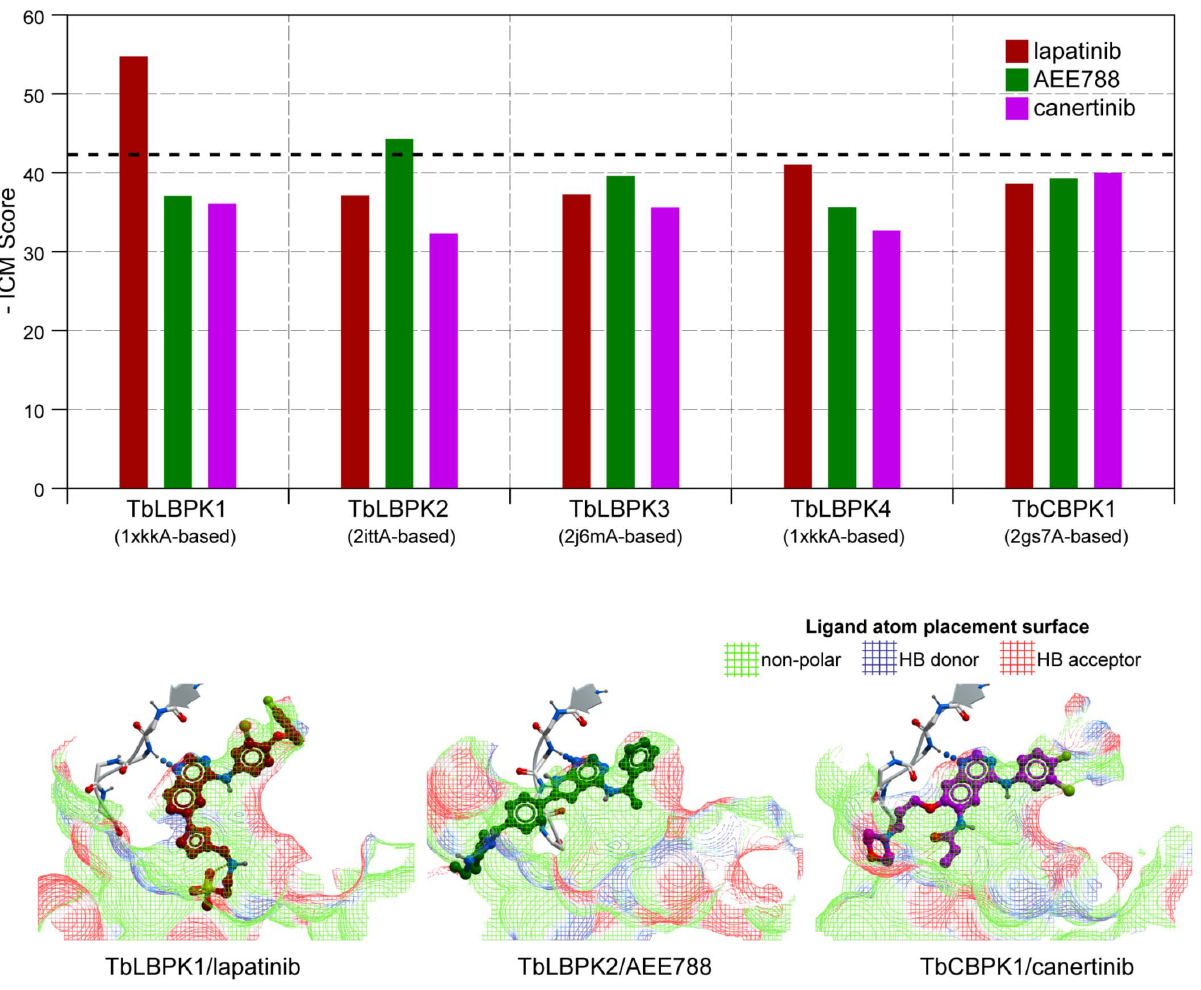
Figure 6. Best models of TbLBPK N drug complexes are consistent with affinity chromatography elution data. ( A ) Predicted ICM binding scores of lapatinib (red), AEE788 (green) and canertinib (magenta) in the binding pockets of the protein kinases. The dotted line represents a hypothetical cutoff for kinase elution by drug after an NAD + wash of the affinity column. ( B ) Predicted binding poses for lapatinib (red), AEE788 (green) and canertinib (magenta) to their highest affinity protein kinases; TbLBPK1, TbLBPK2, and TbCBPK1, respectively. Kinase hinge region is shown in ribbon, ligand atom placement surface is represented by a wire mesh and colored according to its binding properties.